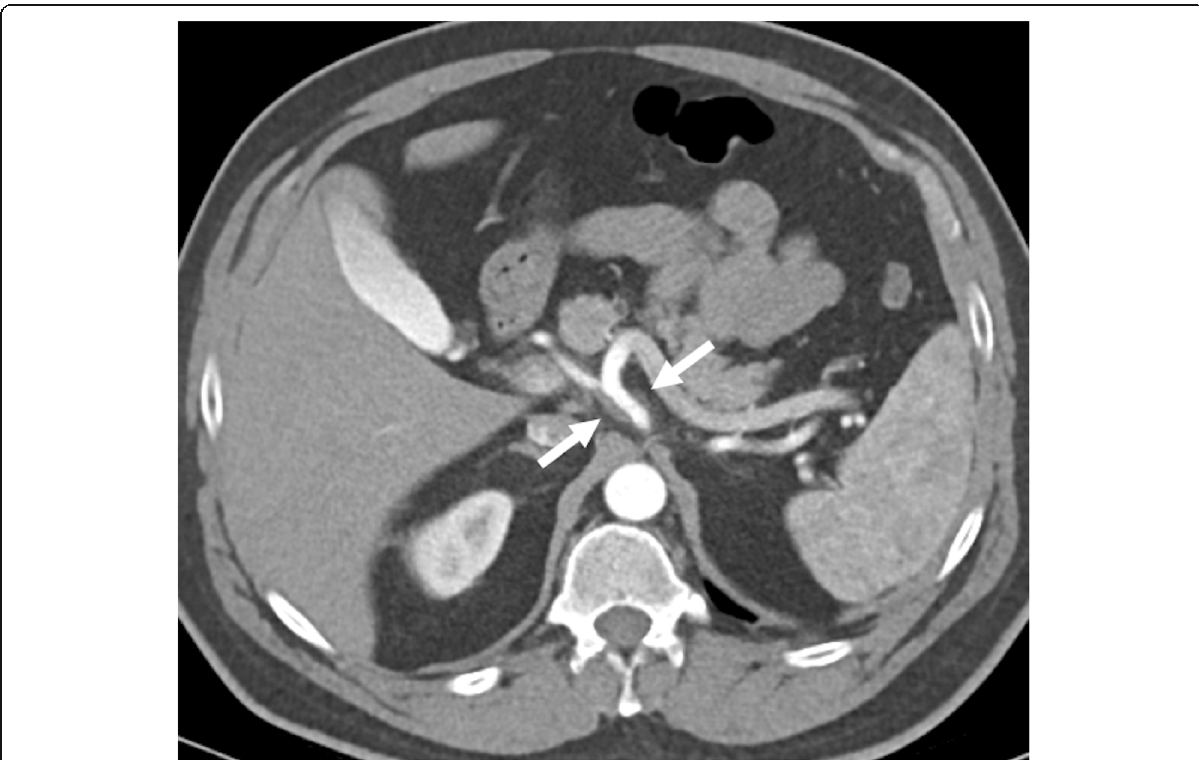
Fig. 26 Celiac artery dissection. A 47-year-old heavy smoker male with known hypertension presented to ED with sharp epigastric pain. Axial plane post-contrast image shows thickening of the celiac artery wall (arrows) suggestive for intramural hematoma and celiac artery dissection. The patient responded well to conservative medical treatment and follow-up imaging study confirmed the regression of intramural hematoma (not shown)